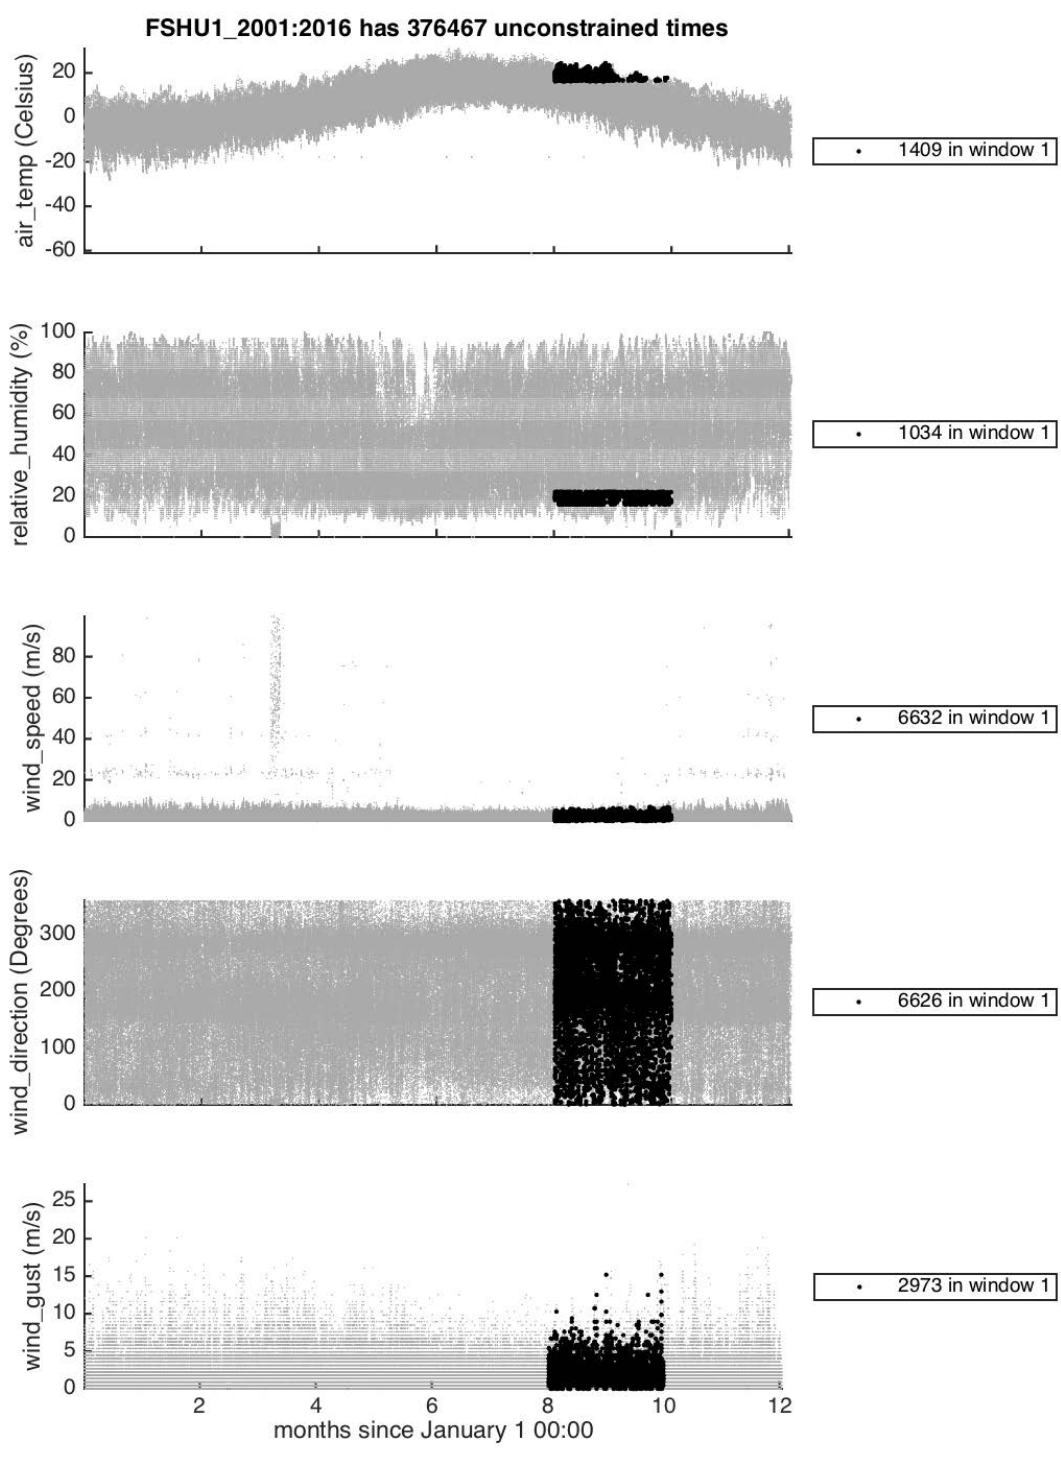
Figure 3. Station data (vertical) vs. month number (horizontal) for station FSHU1 (Fish Lake ranger station near Koosharem 10ENE, 38.55167° N, 111.72278° W, 8880 ft in Utah) in years 2001–2016. Points that do and do not meet the burn-requirements (Table 2) are dark and light gray, respectively, and enumerated in the legends and titles, respectively. The abscissa is t ( mod 12 ) for all the years indicated in the